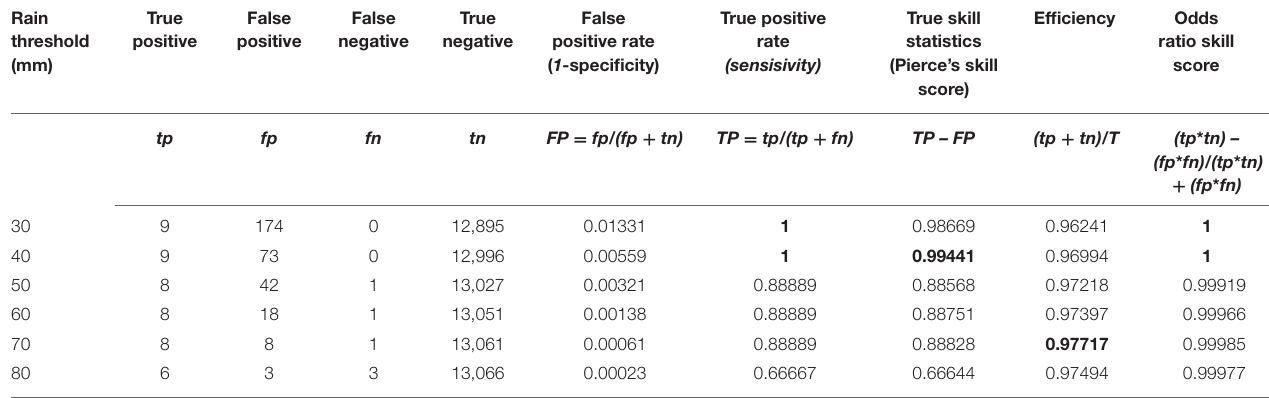
TABLE 4 | Classification of rainy days with different thresholds combined with flash flood events and results of related accuracy statistics (the best scores are in bold letters). True Rain positive threshold (mm)